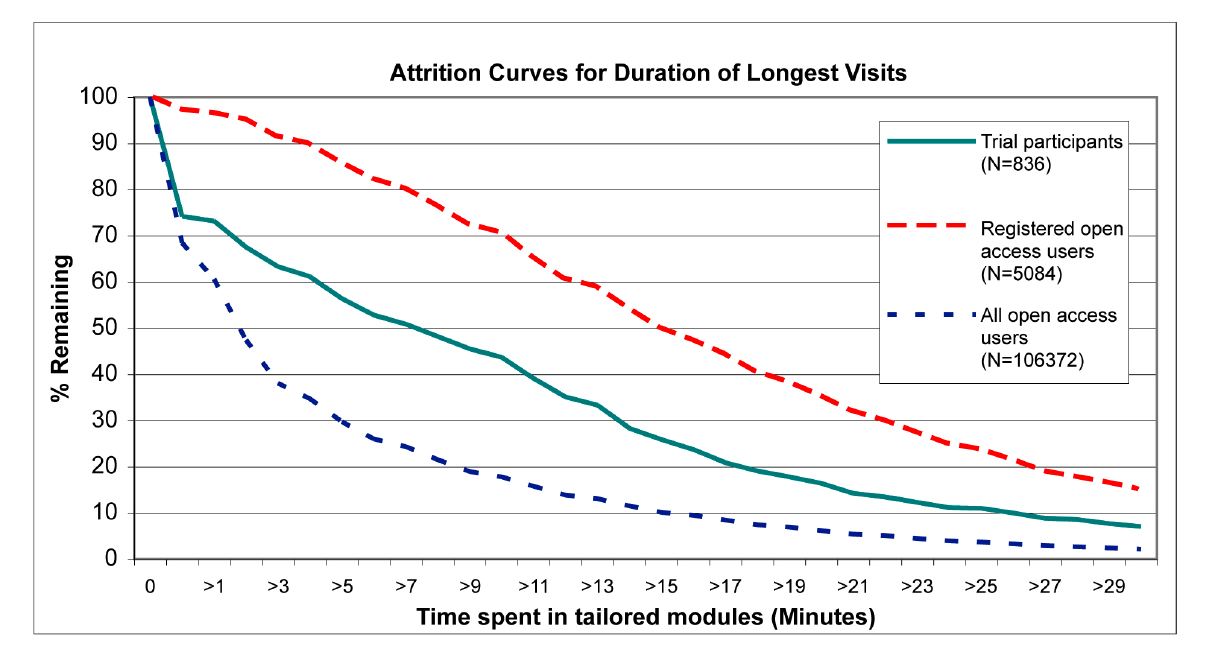
Figure 7. Attrition curves for the duration of the longest visit for open access users and trial